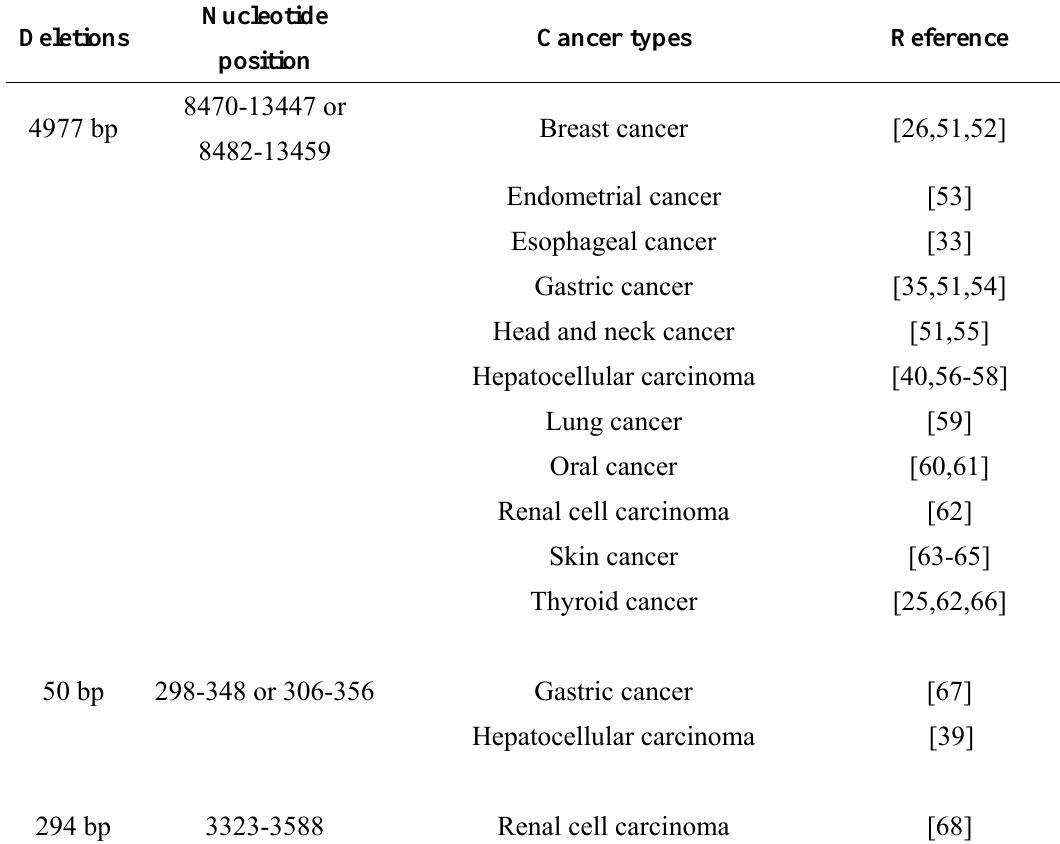
Table 3. MtDNA deletions in human